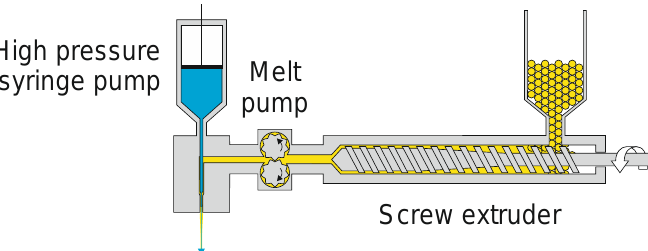
Figure 13. Schematic of liquid-core fiber production. By way of illustration, polymer and liquid are represented in yellow and blue, respectively.